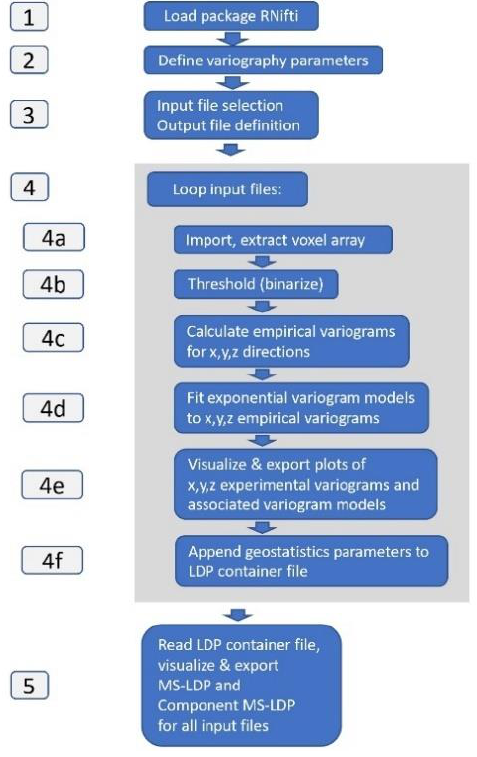
Figure 4. LDPgenerator.r program and data flow chart, indicating sequence of operations (blue labels) involved in generating MS-LDP. Grey labels are code sections, central processing loop is on grey background.